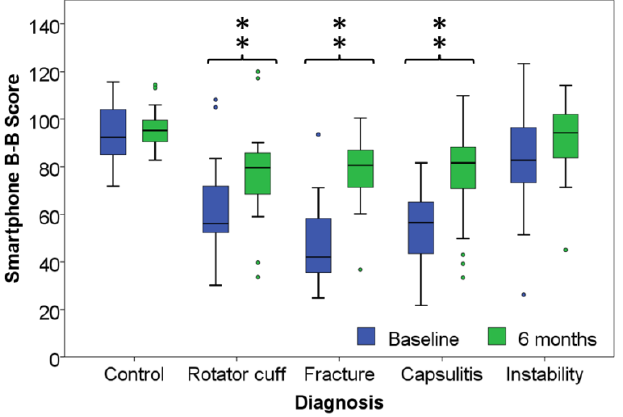
Figure 3. Outcome of the B-B Score for the control group and the pathology groups. ** : significant difference with the control group p < 0.01.